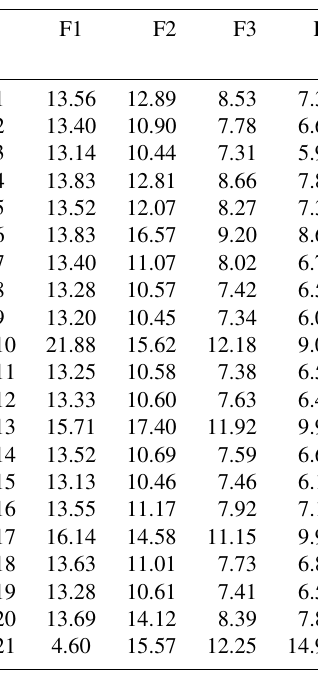
Table 15. The efficacy coefficient scores of 21 debris flow catchments.